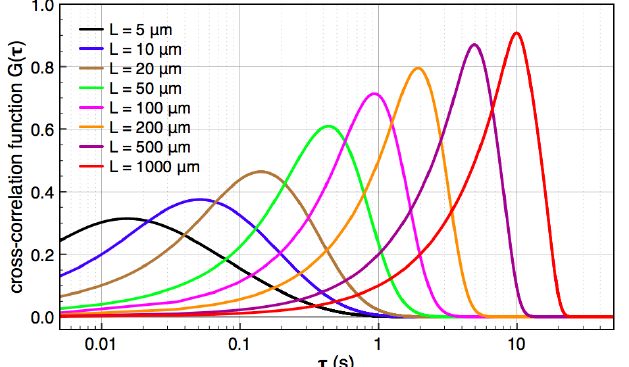
Figure 6. Analytical cross-correlations function as a function of electrode length for in between the consecutive sensors. The cross-correlation peaks are more pronounced with increasing L and shift to longer .